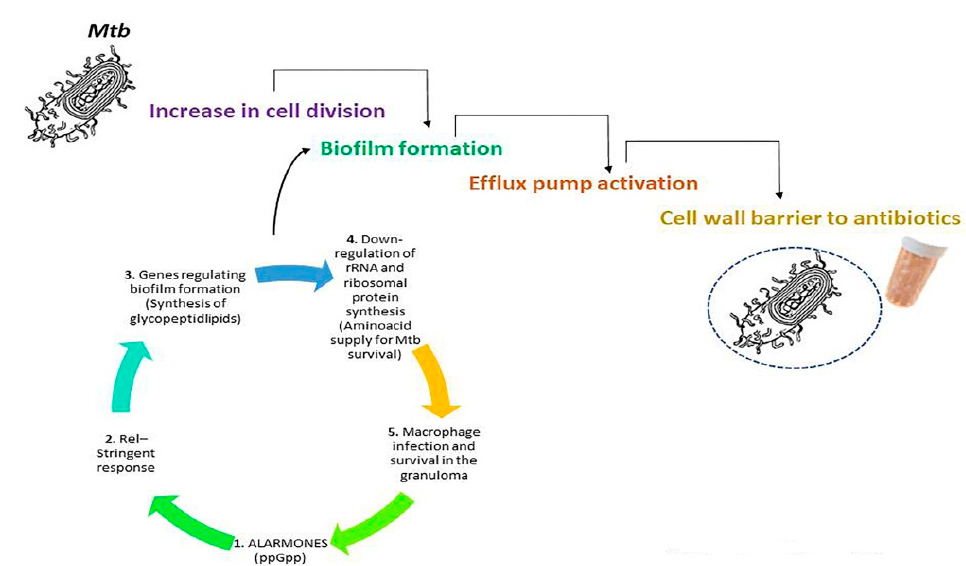
Figure 2. Mtb -induced mechanisms of antibiotic resistance. Stringent response elaborated by Mtb relies on Rel enzyme through the activity of alarmones. Synthesis of glycopeptidolipids contributes to the formation of biofilms, which increase resistance to antibiotics. Increased supply of amino acids allows Mtb to survive for years inside macrophages in the context of granuloma.